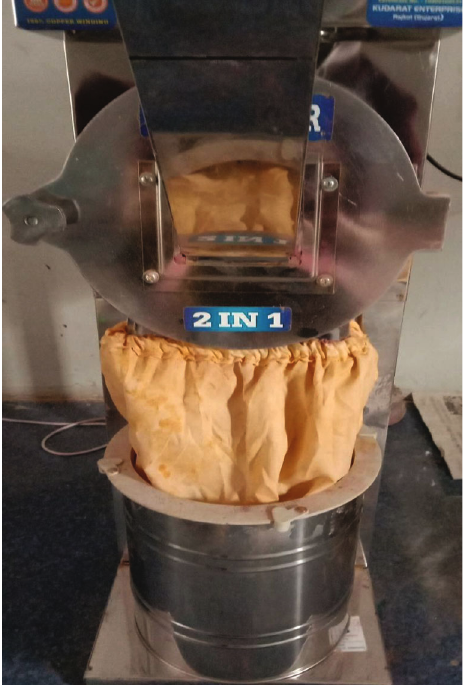
Figure 2: Showing the mini pulveriser machine, where the powdered fl owers are collected in the stainless-steel collecting drum placed at the bottom.